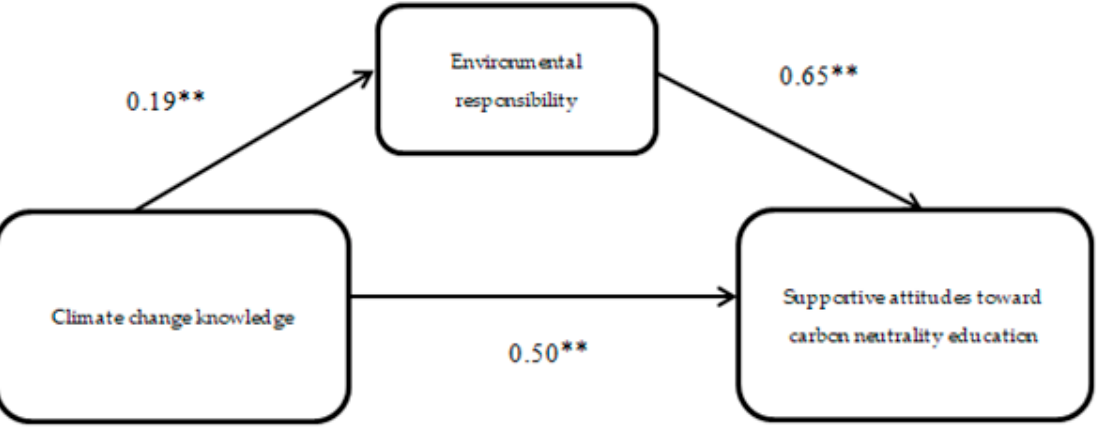
Figure 2. Model of supportive attitudes toward carbon neutrality education. Note: ** p < 0.01.